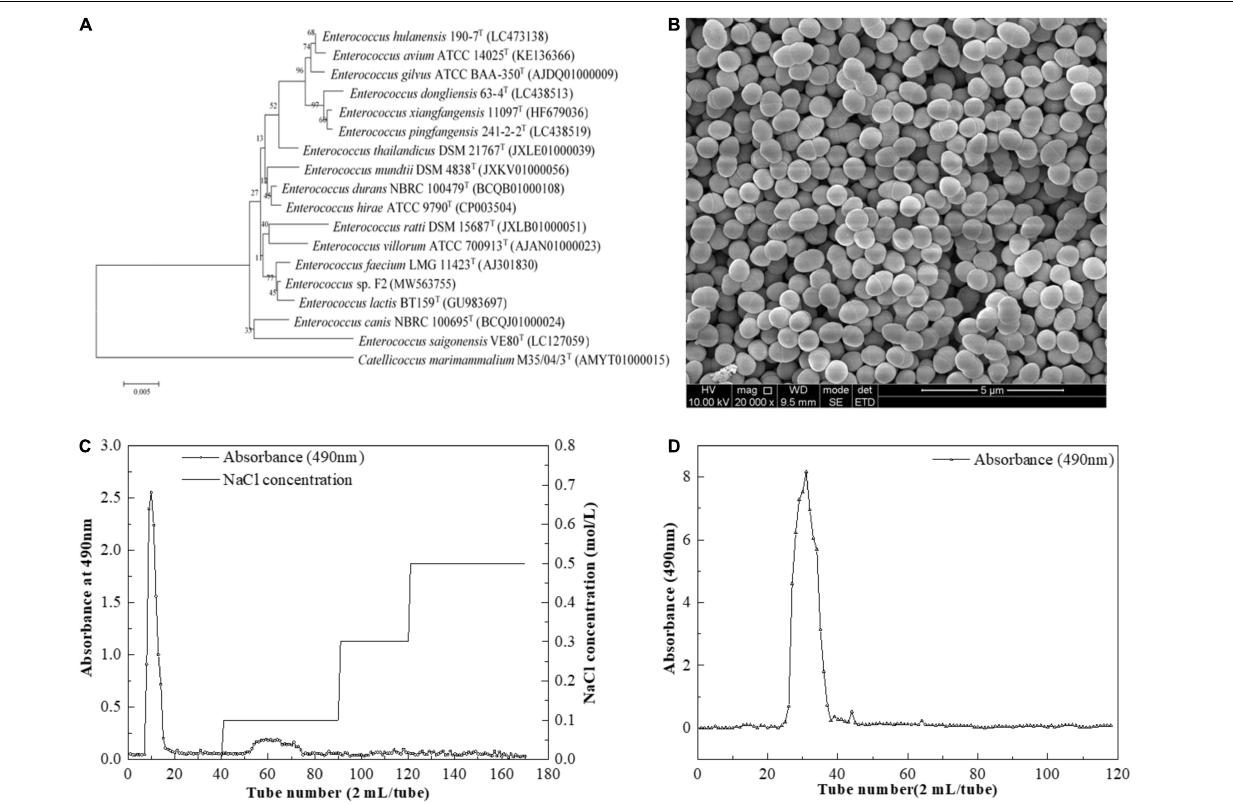
FIGURE 1 | (A) Neighbor-joining tree based on 16S rDNA sequences showing genetic relatedness between Enterococcus sp. F2 and related species; (B) SEM images of Enterococcus sp. F2 (C) DEAE-52 anion-exchange chromatogram; (D) Sephacryl S-400 HR chromatographic profile.